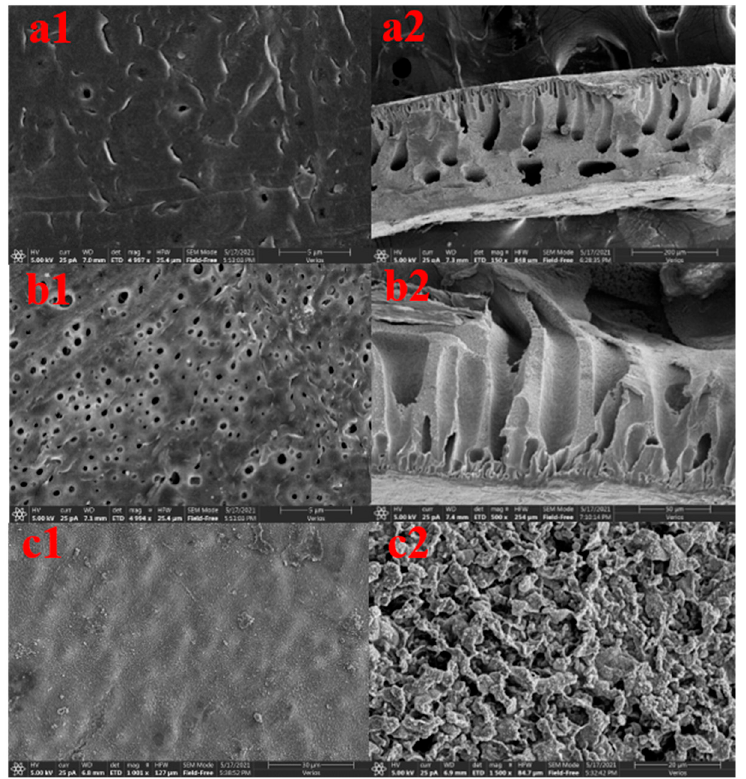
Figure 2. The CFGO ultrafiltration membrane with the best ratio and the ultrafiltration membrane with the worst removal performance of sulfapyridine at 5000× magnification. ( a1 , b1 ) SEM images of the lower surface; ( a2 , b2 ) SEM images of the cross section; and ( c1 , c2 ) SEM images of CFGO.